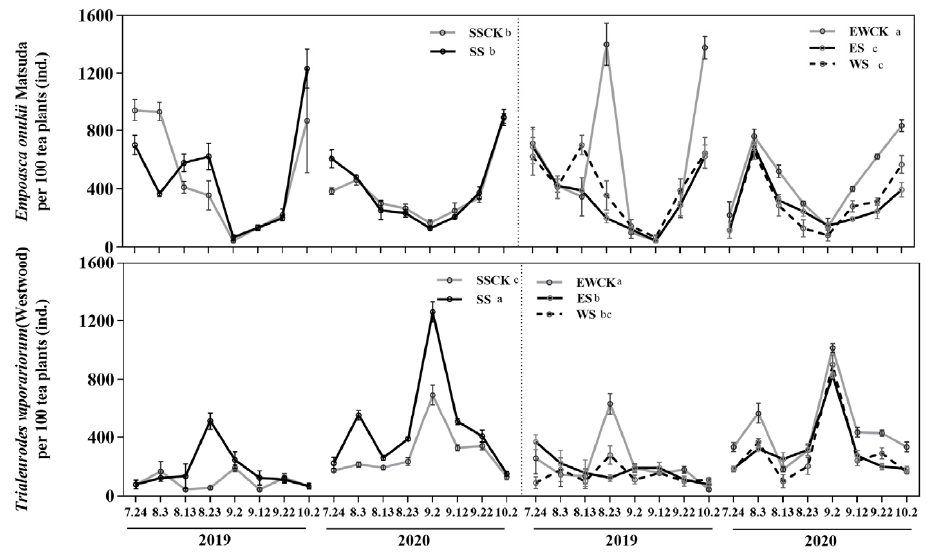
Figure 5. Population dynamics of two key species of insect pests, Empoasca onukii and Trialeurodes vaporariorum under the intercropped maize ecological shading in tea